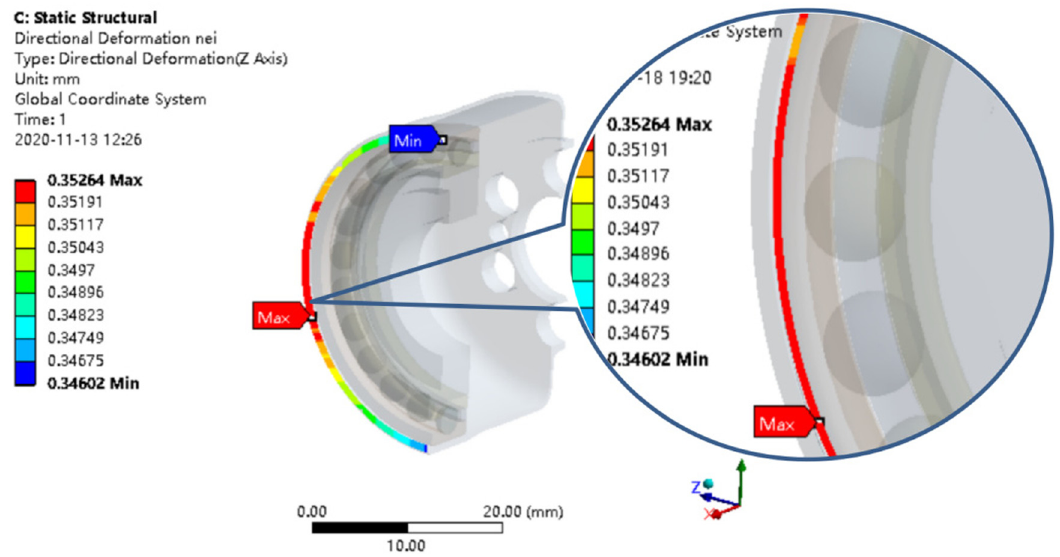
Figure 10: Radial deformation of inner surface of